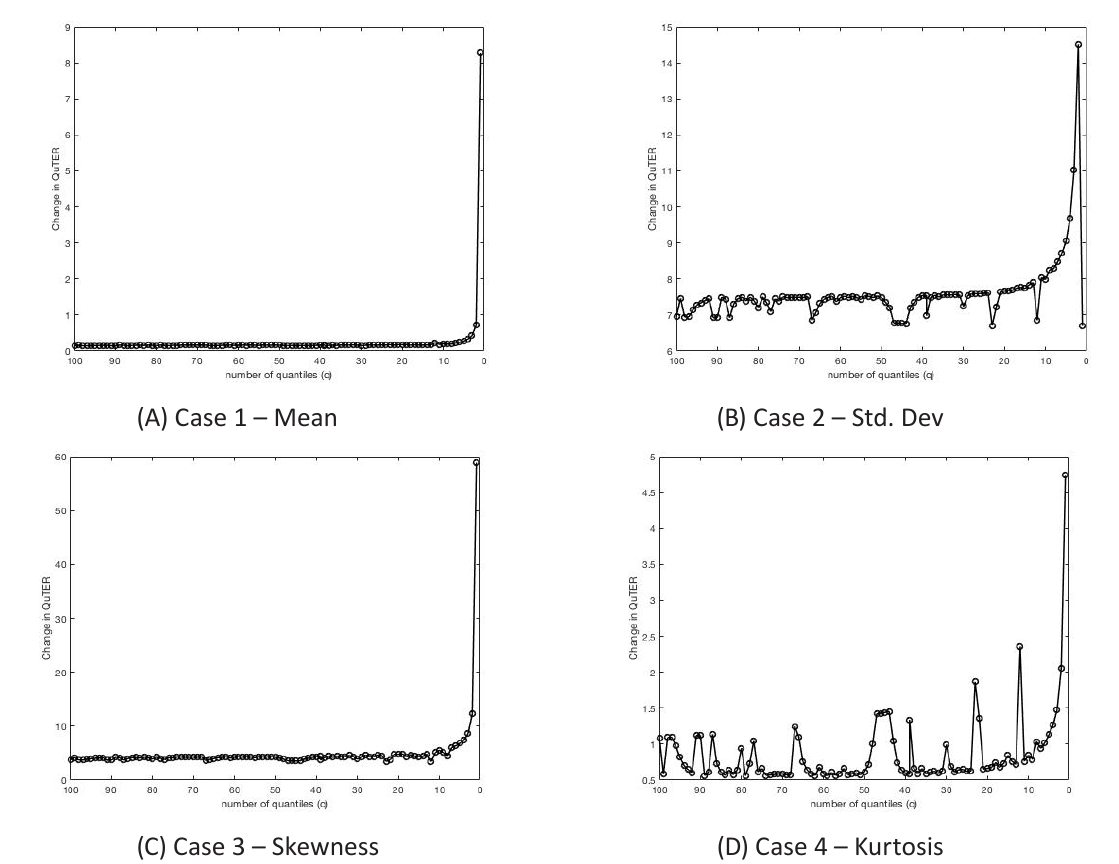
Figure 3. Granularity of grid for the